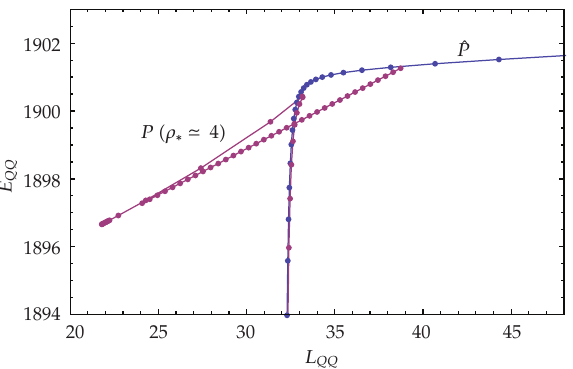
Figure 14: The energy E QQ as a function of the quark-antiquark separation E QQ (cid:5) L QQ (cid:6) . The two solutions in Figure 9 with ρ ∗ (cid:8) 0 and ρ ∗ (cid:9) 4 are used for the background, and the results are shown using the same color-coding as in Figure 9 (cid:3) 58 (cid:4)